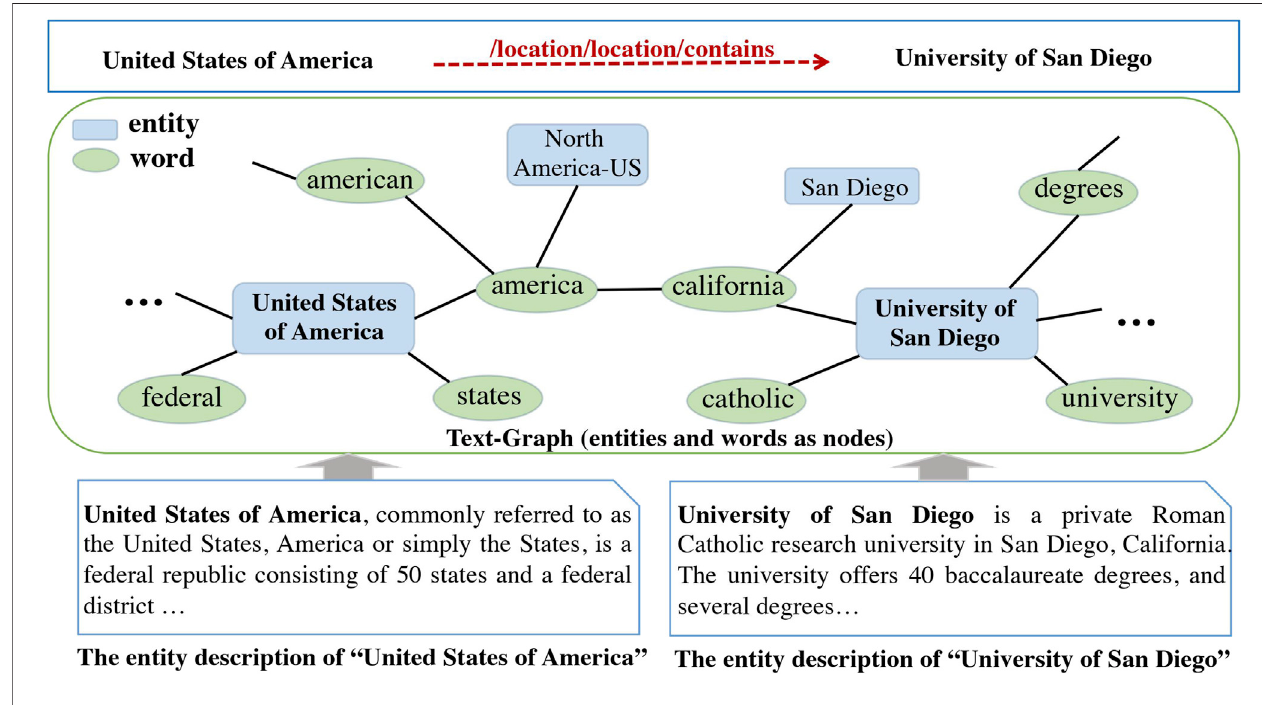
FIGURE 1 | An example of text-graph. The entity University of San Diego is connected with the entity San Diego by words in their text descriptions. Leveraging the semantics in the text-graph could bene fi t the prediction of the link (United States of America,/location/location/contains, University of San Diego).